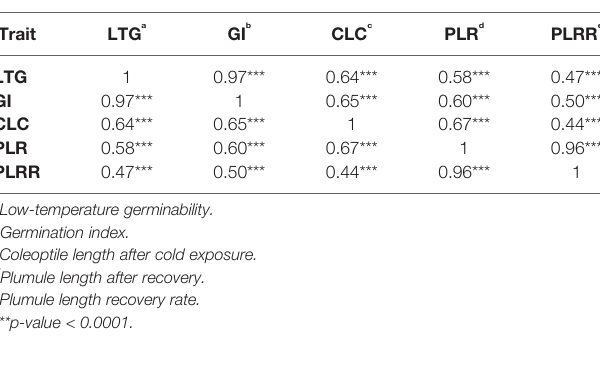
TABLE 3 | Correlation analysis of different cold tolerance traits among all accessions.